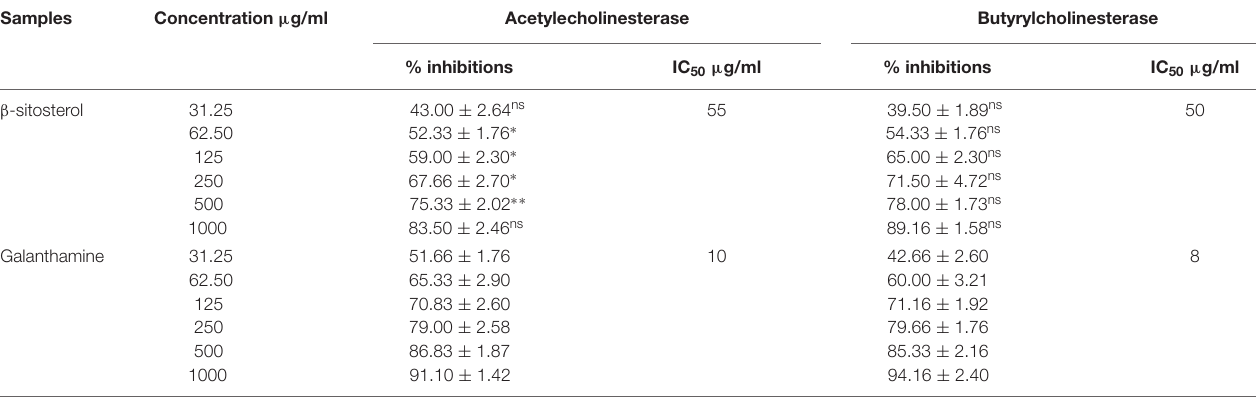
TABLE 2 | Results of in vitro cholinesterase inhibitory potential of β -sitosterol. Samples Concentration µ